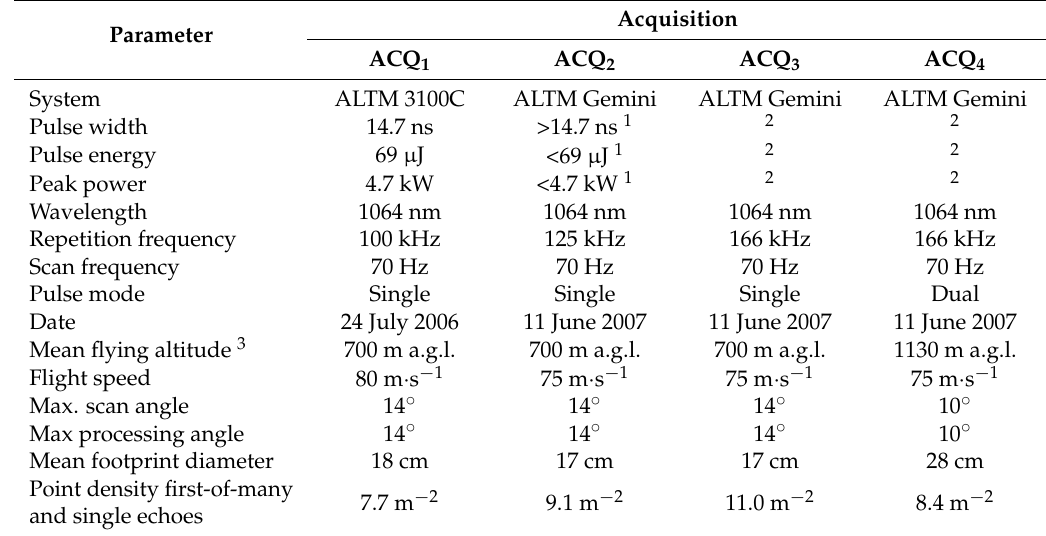
Table 3. Summary of laser scanner data and flight parameters of the four laser data